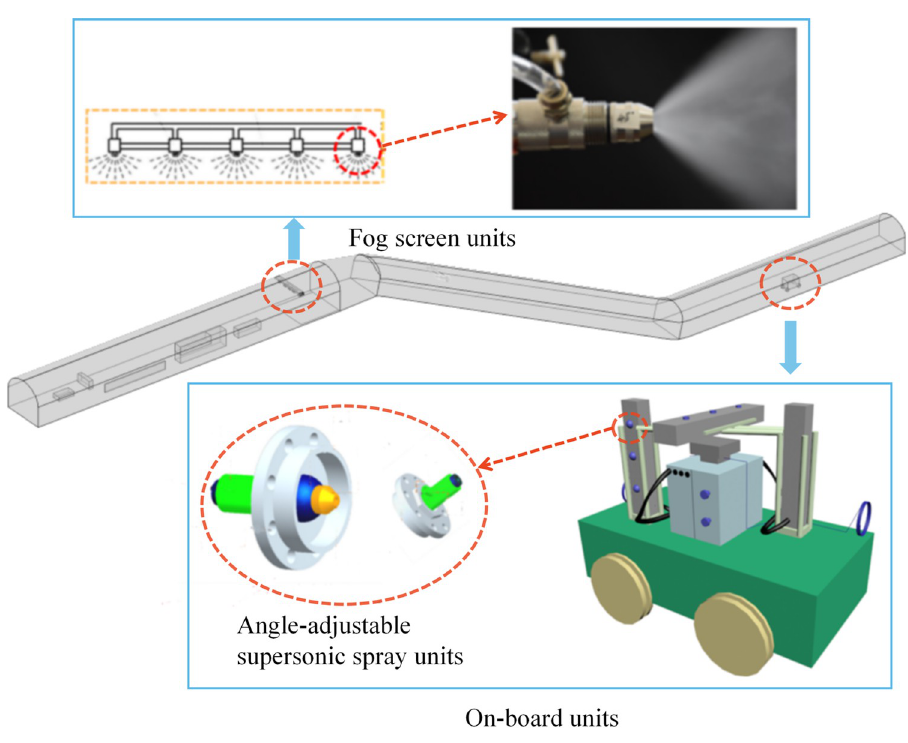
Fig 4. Dust control technology device.